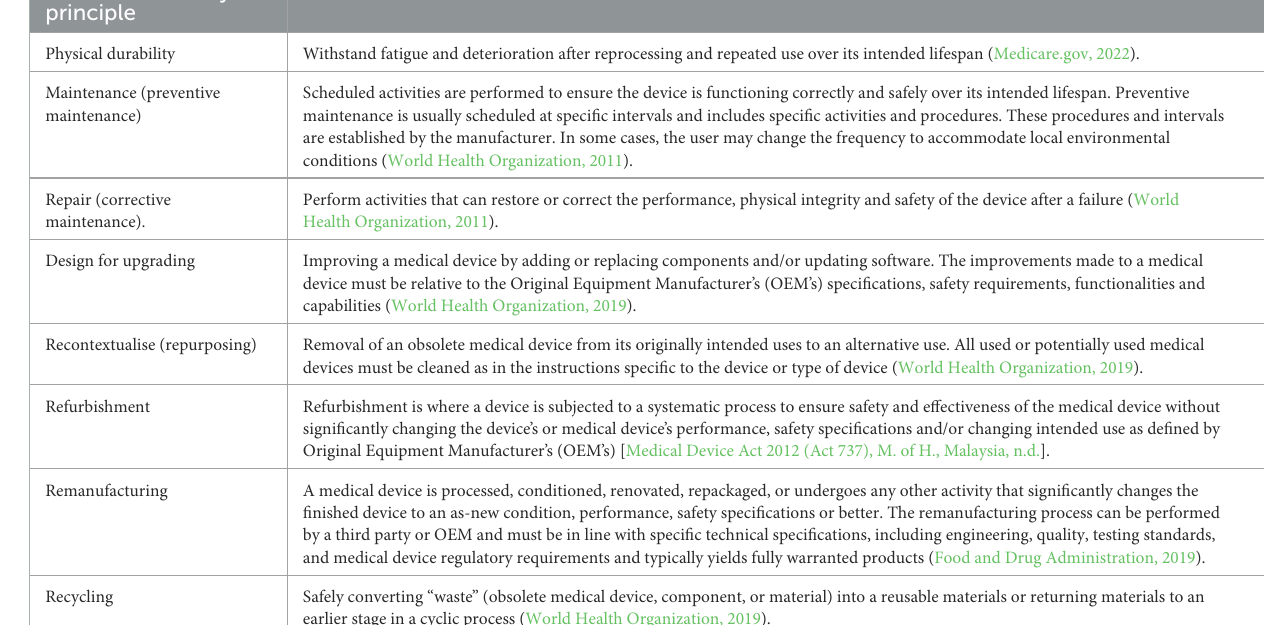
TABLE 1 Circular economy design principles from a medical device perspective as inferred in literature. Circular economy